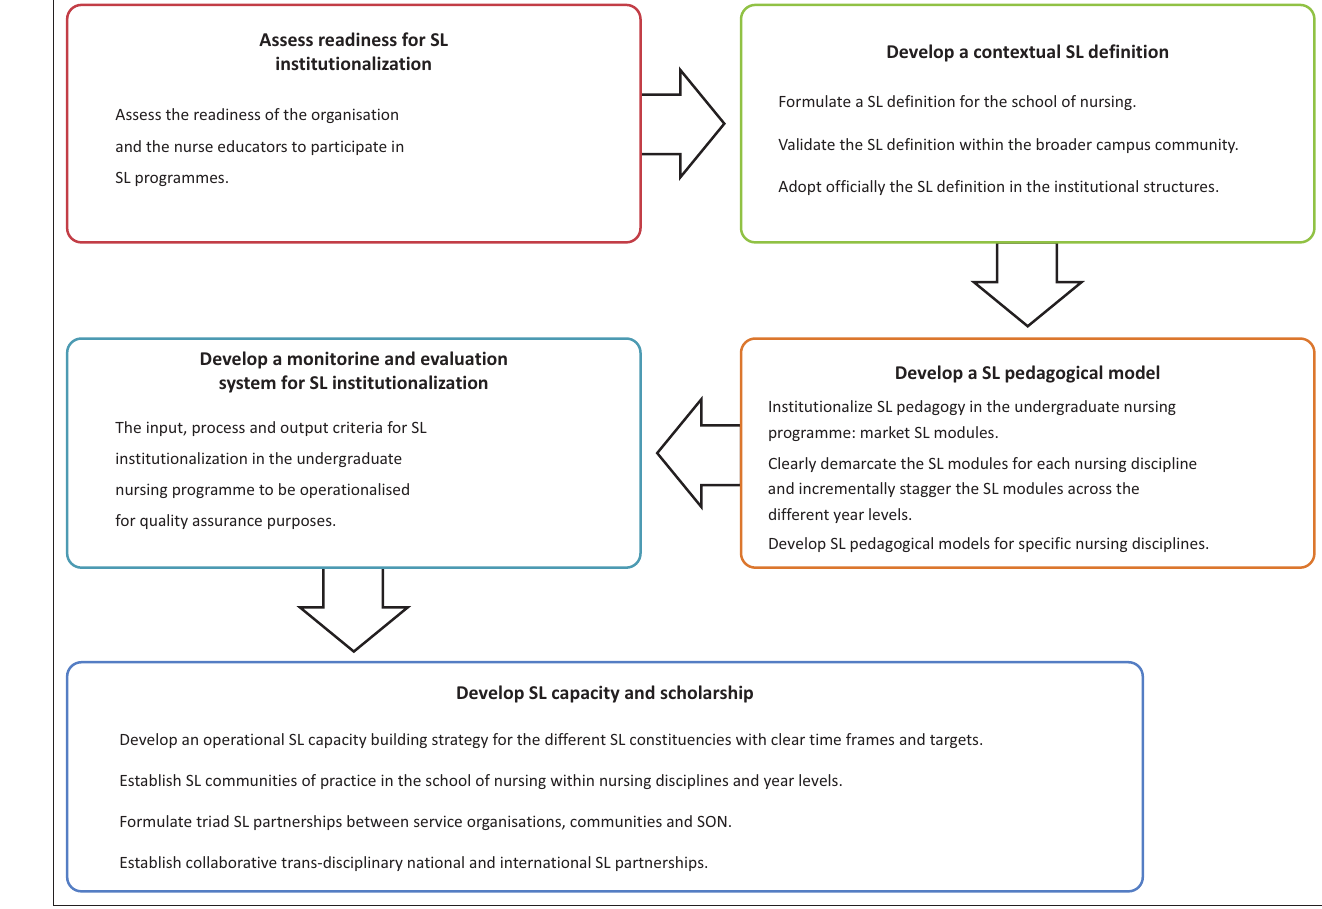
FIGURE 2: Prescriptive elements of the service-learning implementation